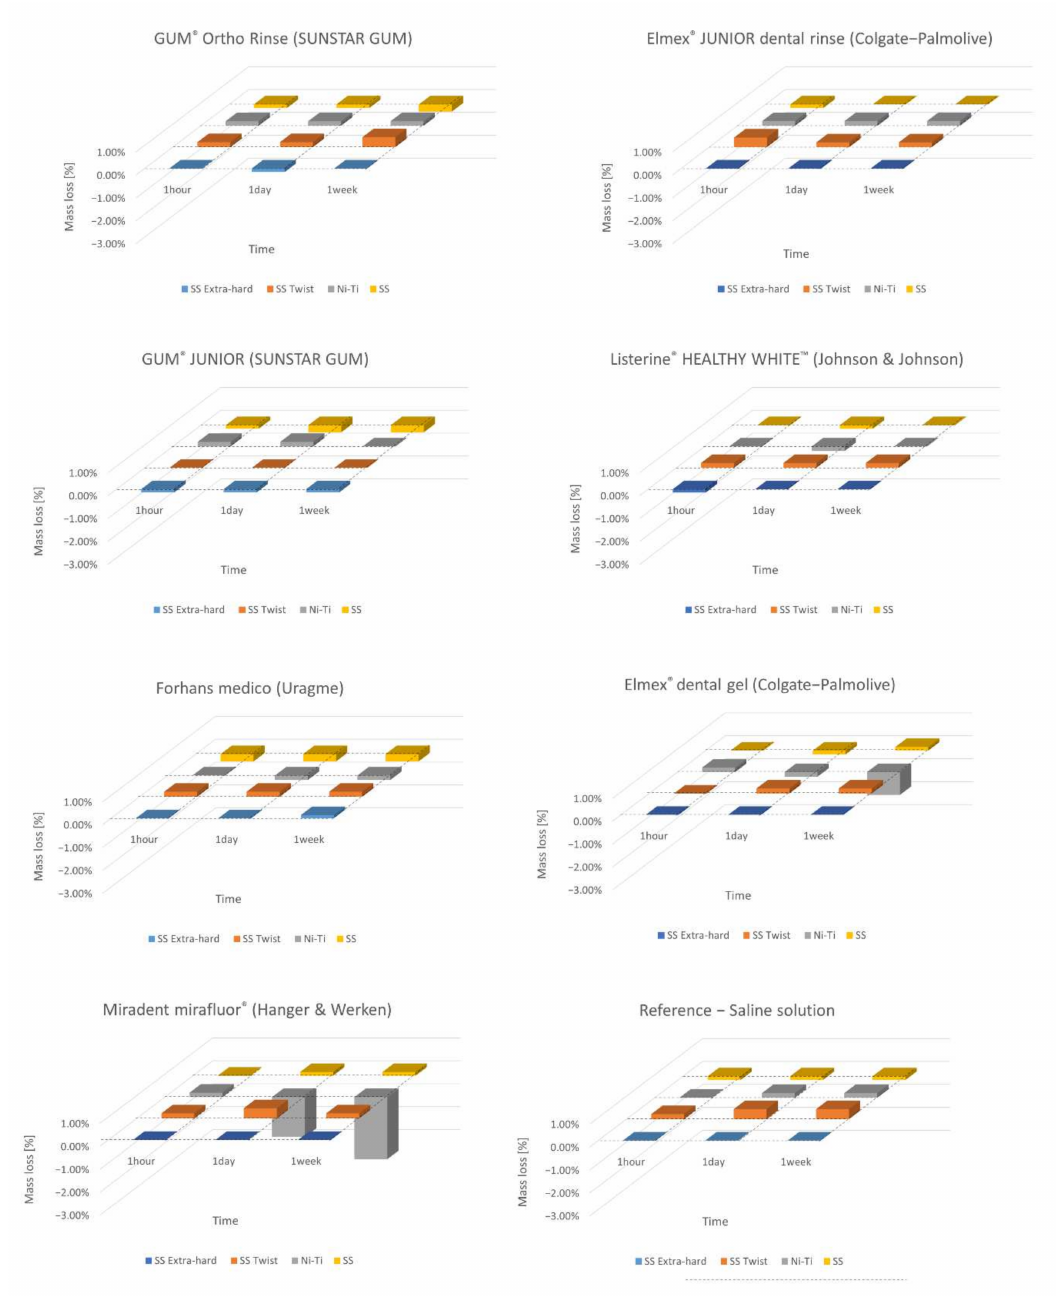
Figure 1. Differences in weight percentage of the 96 orthodontic arch section samples ( n = 24) after 1 h (t 1 ), 24 h (t 2 ) and 168 h (t 3 ) of storage in the different fluorinated agents. One-way ANOVA for each individual substance in which the four different orthodontic alloys were immersed for three different time intervals has been performed. The weighted average of the five weighings was calculated and finally the relative difference from the initial weight was